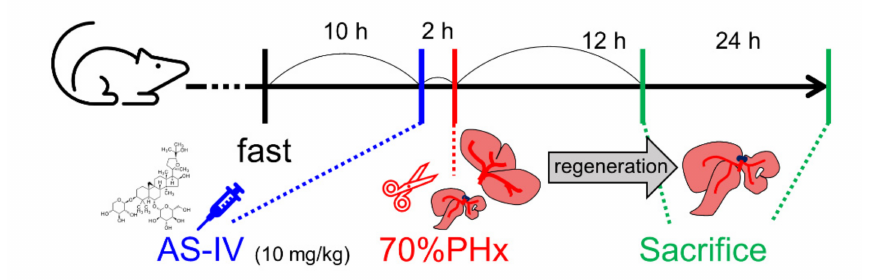
Figure 7. Administration of AS-IV and 70% PHx. Rats were received 10mg/kg of AS-IV diluted in D.W. (experimental group) or D.W. (control group) 2 h before 70% PHx and were sacrificed at 12 h or 24 h after